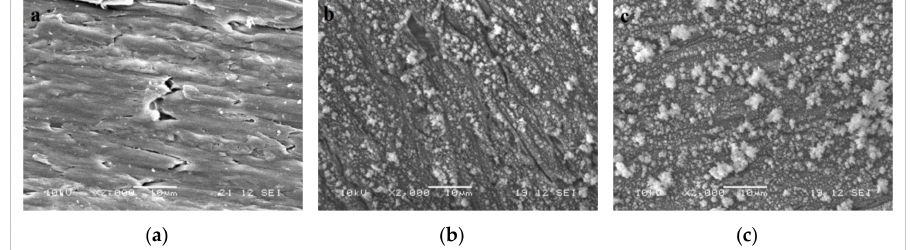
Figure 3. Scanning electron microscope (SEM) images of ( a ) uncoated wood and ( b ) TiO 2 -coated wood at v = 80 mm / s, ( c ) TiO 2 -coated wood at v = 40 mm / s.